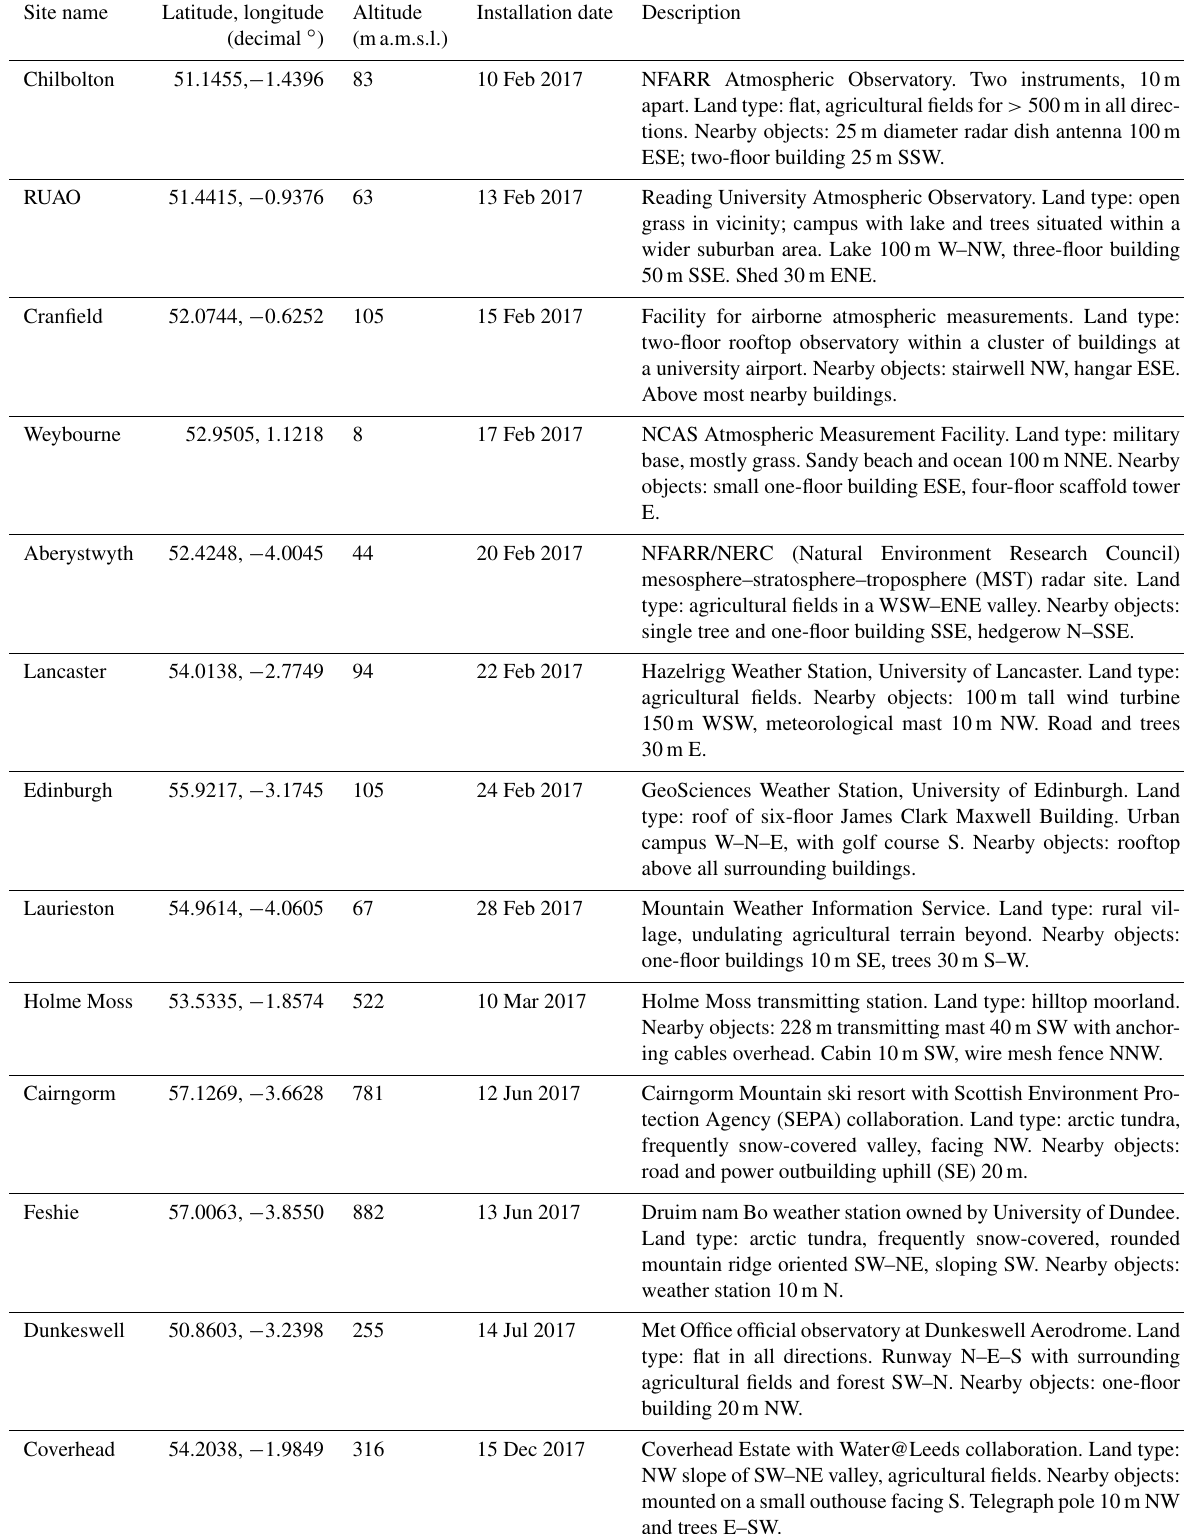
Table 3. Site location descriptions of disdrometers in the Disdrometer Verification